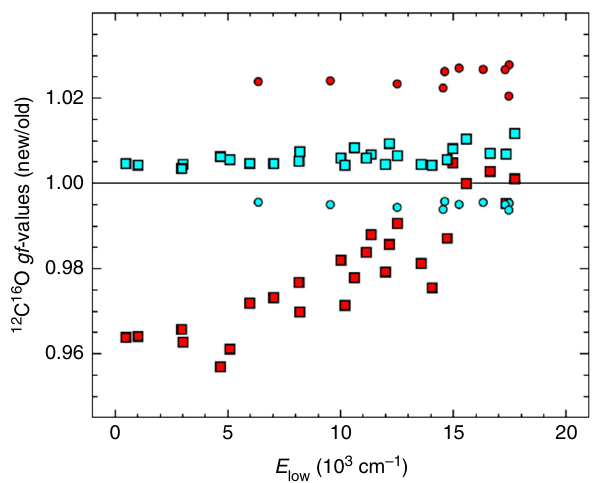
Fig. 2 New 12 C 16 O oscillator strengths. Strengths use the Li et al. dipole moment function 16 for the co-added lines shown in Fig. 1. The oscillator strengths are shown multiplied by the multiplicity, g = 2 J ″ + 1 for lower state rotational quantum number J ″ , and are therefore designated as gf -values. The new gf -values are shown normalized to previously published ( “ old ” ) gf - values, where blue symbols are normalized by HR96 15 , and red symbols are normalized by G94 18 . Circles are for Δ v = 1 transitions, and squares are for Δ v = 2. This fi gure shows that the new gf -values are considerably closer to the gf -values of HR96 15 . The ratio of f -values moves in the opposite direction from Δ v = 1 to Δ v = 2 for HR96 and G94 f- values, causing the 5 – 6% difference in photospheric isotope ratios previously found 12